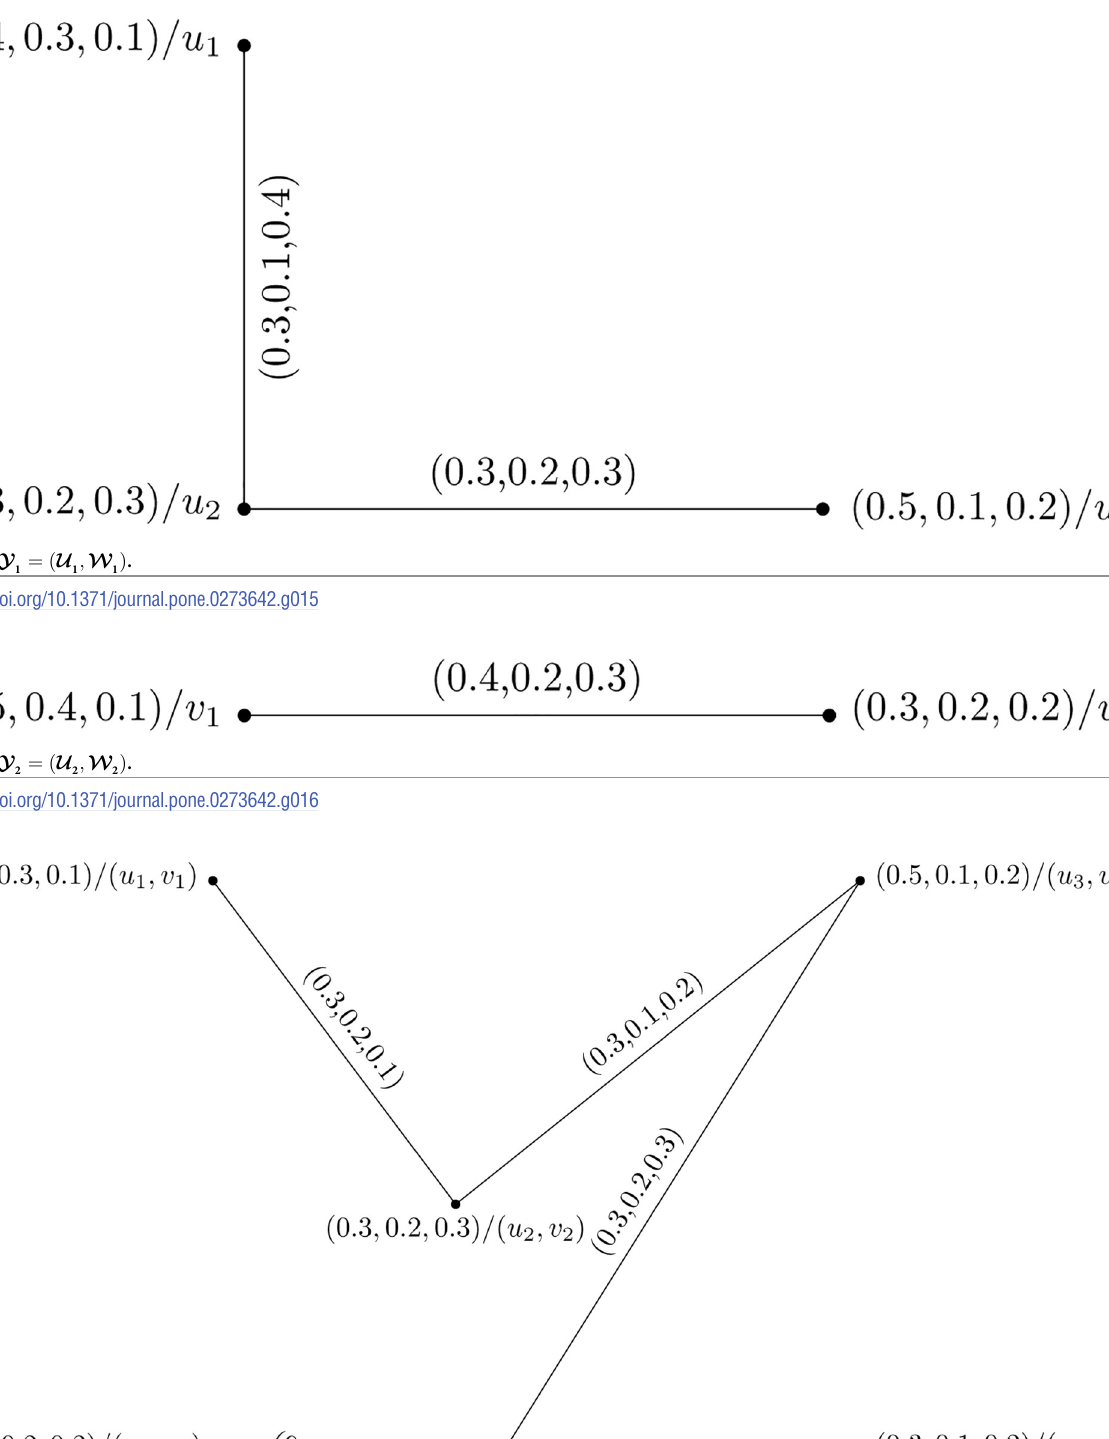
Fig 17. Direct product of picture fuzzy hypersoft graphs. https://doi.org/10.1371/journal.pone.0273642.g017 PLOS ONE | https://doi.org/10.1371/journal.pone.0273642 March 7,